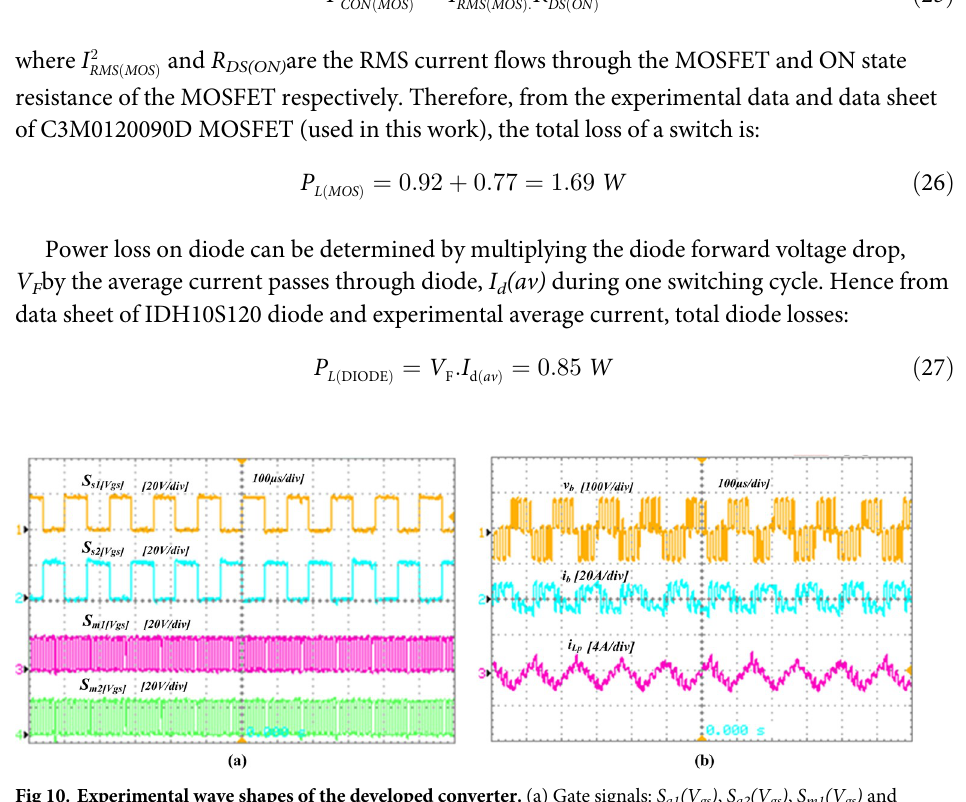
Fig 10. Experimental wave shapes of the developed converter. (a) Gate signals: S S m2 (V gs ) . (b) CW multiplier terminal (or FB) voltage and current, v b and i b respectively, and parallel inductor current,